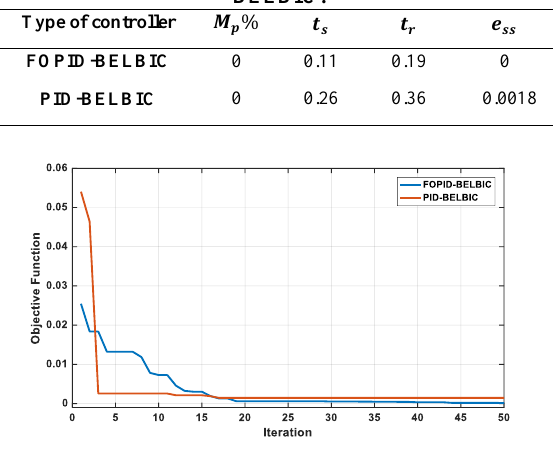
Figure 9. Objective function versus iteration.